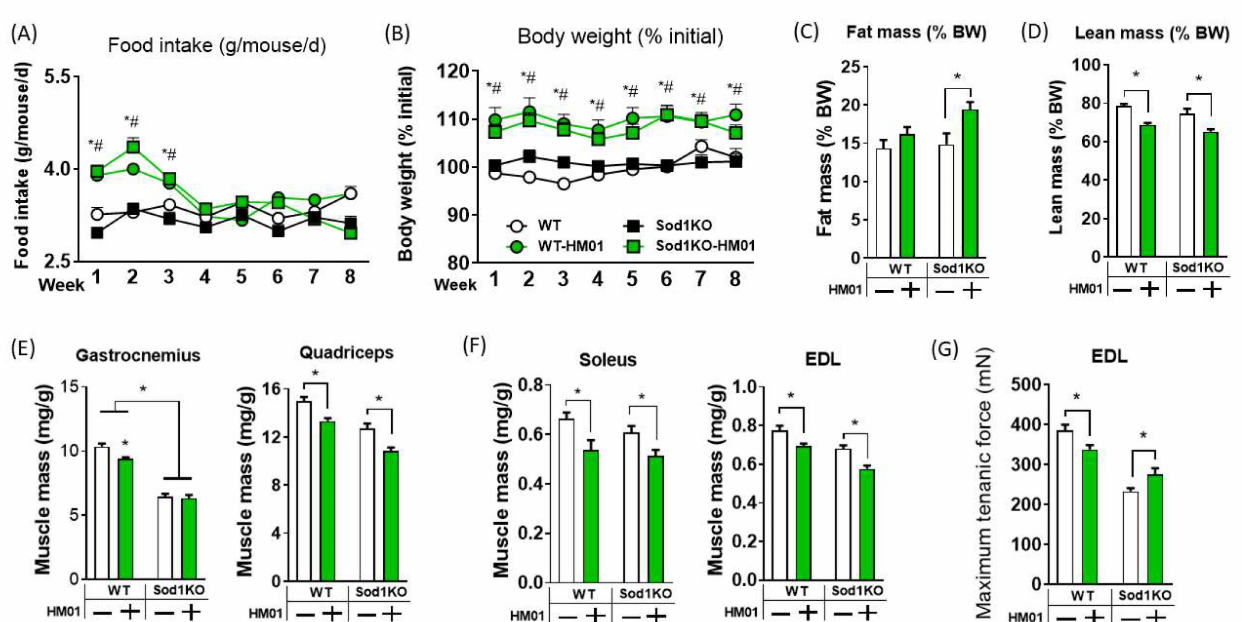
Figure 2. Mice treated with HM01 for eight weeks exhibit loss of muscle mass and reduced maximum force generation. ( A ) Food intake during the eight-week HM01 treatment. * significant difference be- tween WT and WT-HM01. # significant difference between Sod1KO and Sod1KO-HM01. ( B ) Percent body weight relative to initial over eight-week study period. ( C , D ) Percent fat mass and percent lean mass relative to body weight at the study endpoint. ( E ) Gastrocnemius and quadriceps normalized to body weight. ( F ) Soleus and extensor digitorum longus (EDL) normalized to body weight. ( G ) Maxi- mum tetanic force generation of EDL muscle at 200 Hz electrical stimulation. Data are mean ± SEM. Two-Way ANOVAs were used to test statistical significance between groups, followed by Tukey post hoc tests. Data are mean ± SEM. * p <